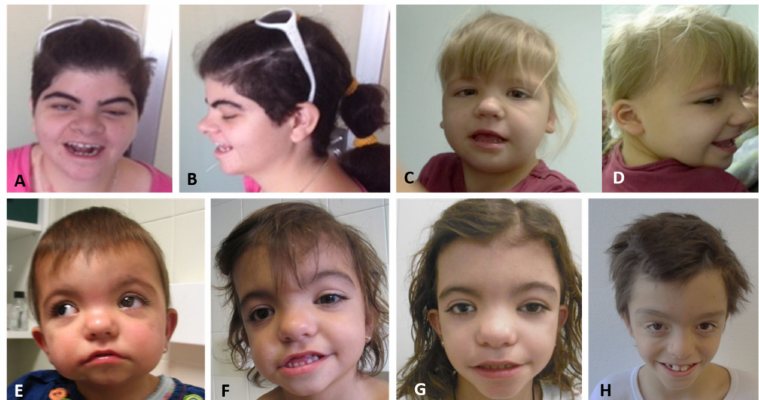
Figure 1. Facial phenotypes of four of the novel patients with PACS1 pathogenic variants. ( A , B ) pa- tient 1; ( C , D ) patient 7; ( E – G ) patient 4 and ( I ) patient